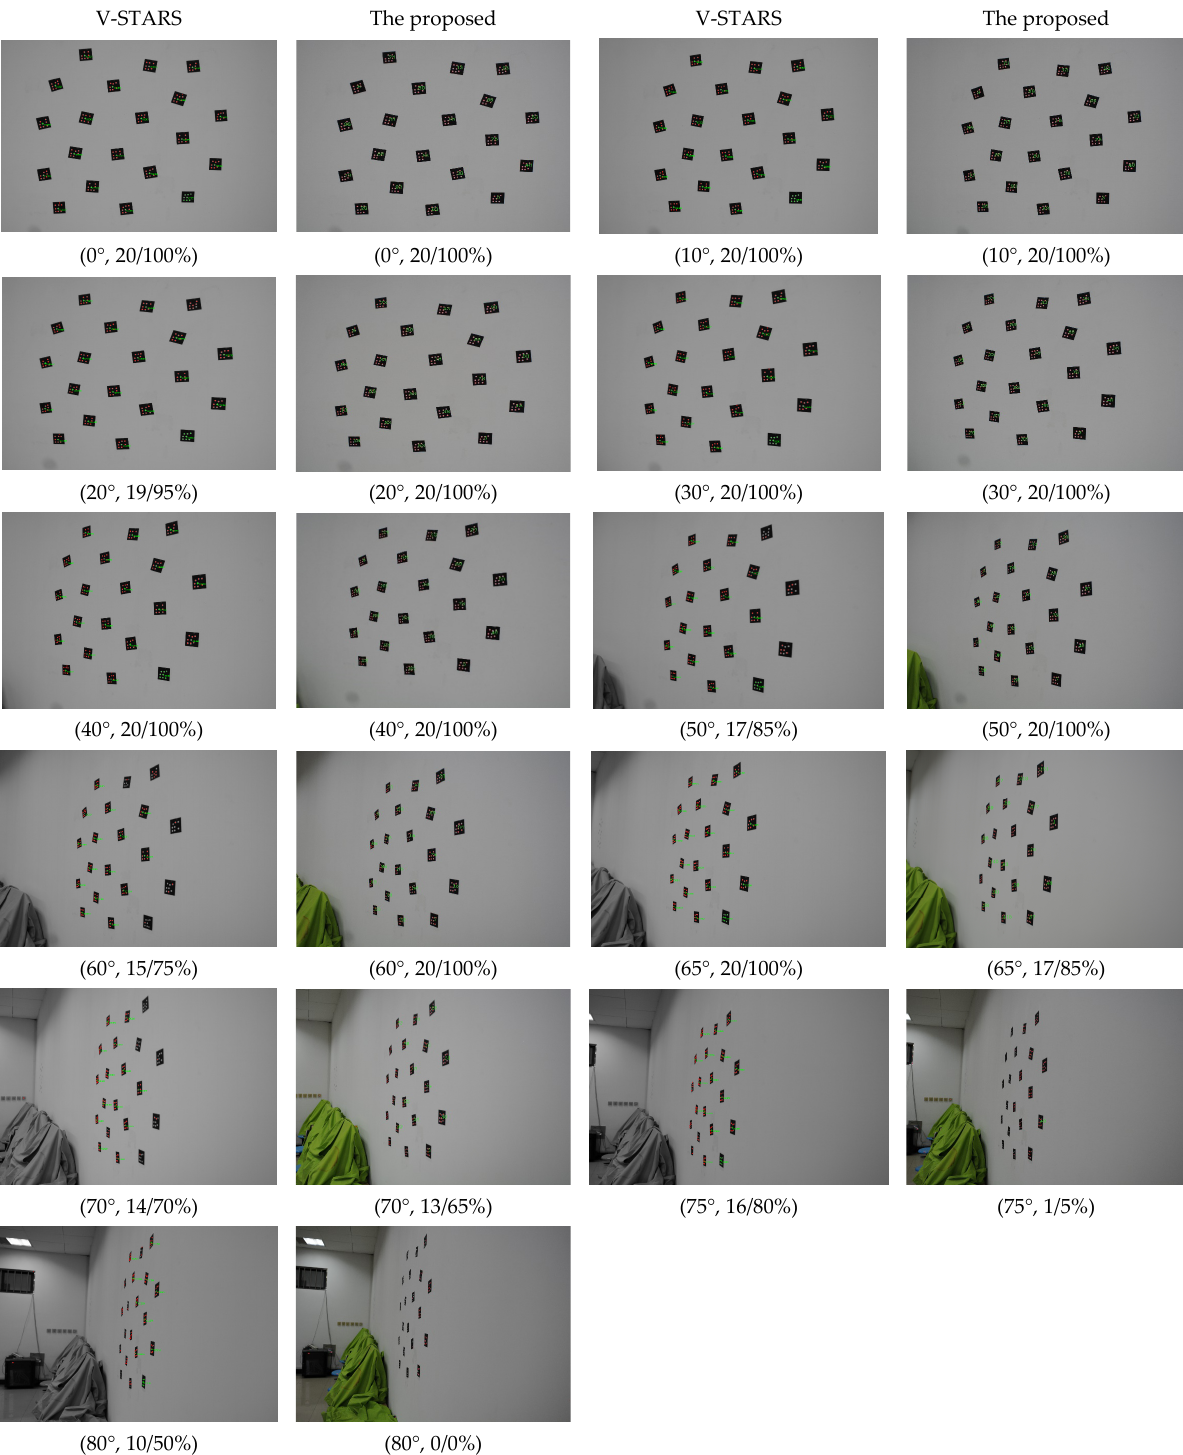
Figure 6. Identification results of different viewing angles with increasing steps for 6 mm GCTs.